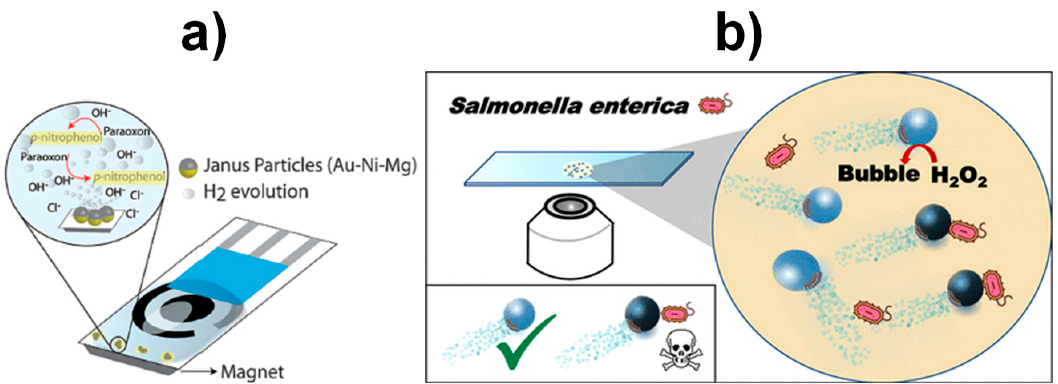
Figure 12. Electrochemical ( a ) and optical ( b ) biosensing using self-propelled spherical magnetic Janus particles. Electrochemical detection of organophosphorous nerve agents through their hydrolysis to non-hazardous, but electrochemically detectable by-product (p-nitrophenol) at screen-printed electrodes ( a ); optical biosensing of enterobacterial contamination by rapid quenching of the native fluorescence of the PABA-functionalized magnetocatalytic hybrid Janus spherical particles upon interaction with the target LPS from Salmonella enterica ( b ). Reprinted and adapted from ( a ) [76] and ( b ) [83] with permission.